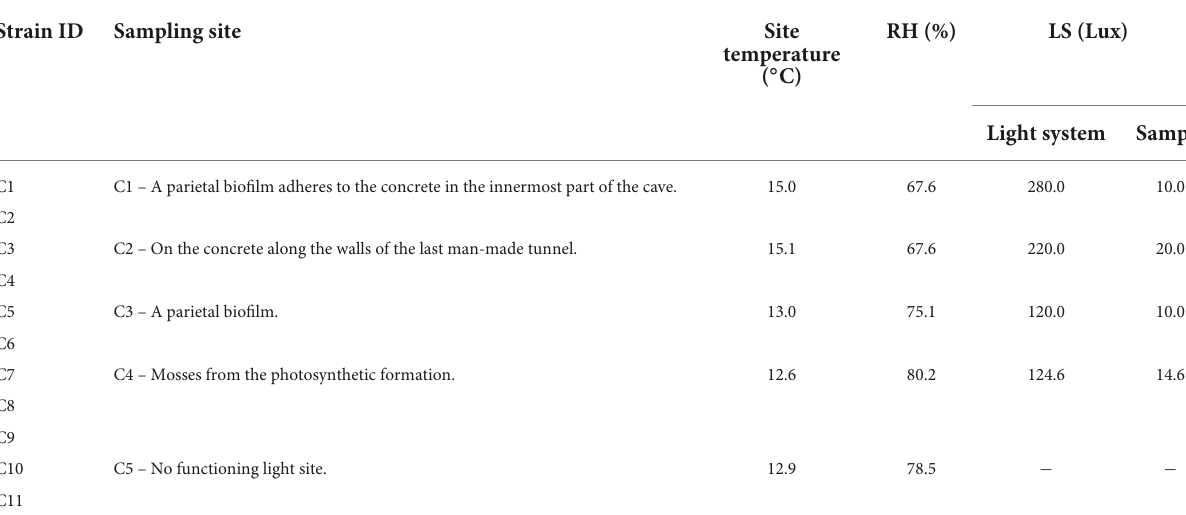
TABLE 1 Cyanobacterial isolates and environmental variables measured at the different sampling sites of “Stiffe”